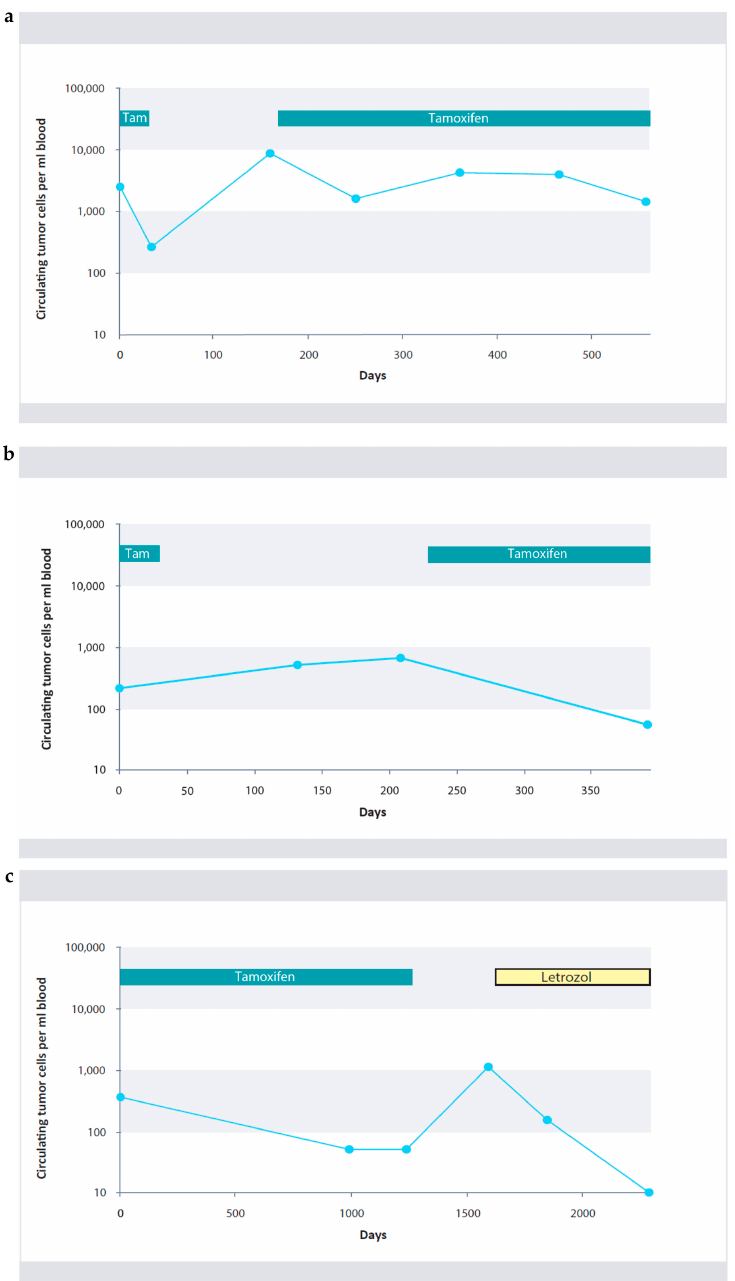
Figure 5. ( a ) Breast cancer (pT1cN0M0G2, HR+, Her2/neu: neg). 4 times TC (taxane and cyclophosphamide). Tamoxifen interrupted because of side effects. Reiinitiation of Tamoxifen. ( b ) Breast Cancer (pT2pN0M0). 6 times FEC (fluoruracil, epirubicine and cyclophophasmide, Herceptin, Radiatio, Tamoxifen interrupted. Reiinitiation of Tamoxifen. ( c ) Breast Cancer (pT2pN2apM0G3) Er+ PR+ Her2/neu FISH neg, 3 times FEC, 3 times Docetaxel, Radiatio, Tamoxifen interrupted, then Letrozol.